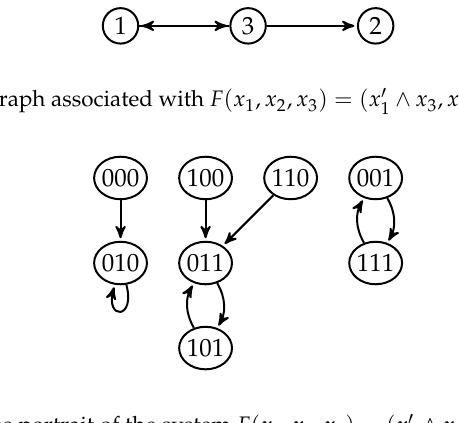
(cid:48) ∨ x ∨ x ) . 3 , x 3 , x 3 2 1